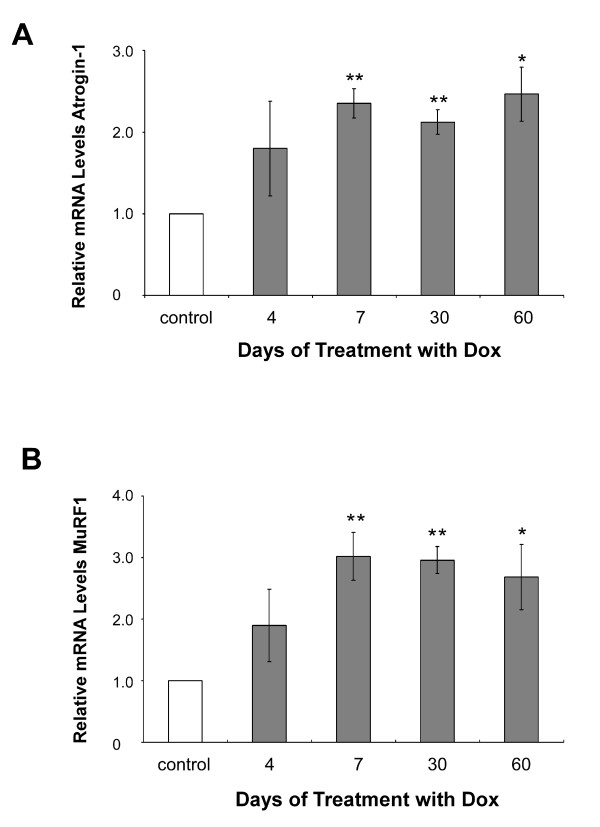
Real-time PCR analysis of Atrogin-1 and MuRF1. qRT-PCR analysis of Atrogin-1 (A) and MuRF1 (B) gene expression in RNA samples from Tg(HQK) mice relative to similarly treated wild-type control mice. Measurements of relative gene expression for 4 time points (over 4–60 days) in mice following treatment with 6 g Dox/kg food beginning on day 0. Total RNA was extracted from skeletal muscles (quadriceps) from the hind legs and subjected qRT-PCR analysis. Results represent the mean ± s.e.m. of triplicate measurements performed. * p < 0.01; ** p < 0.001.